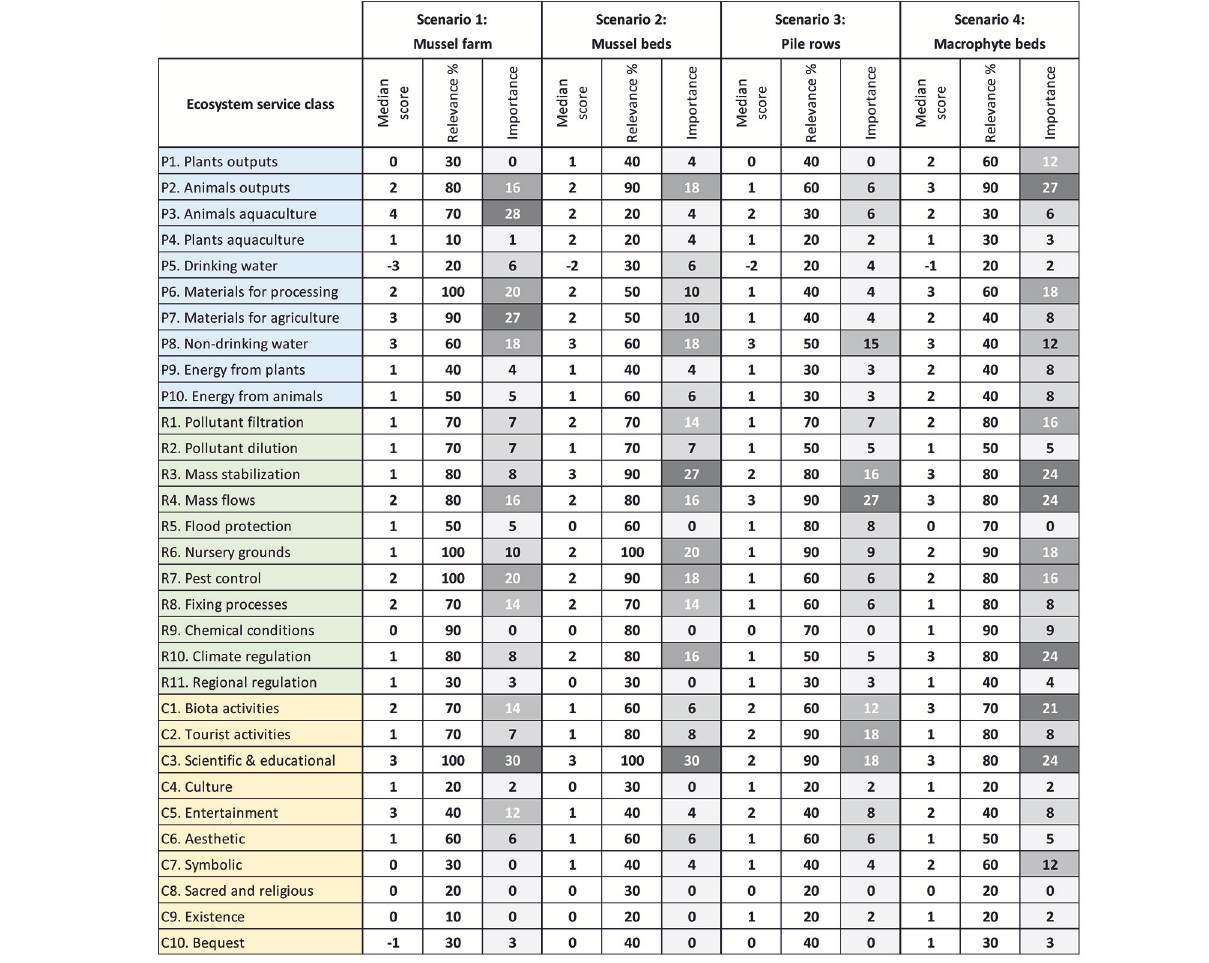
to reconsider scores. We possibly would have received a more unified assessment and much lower standard deviations of